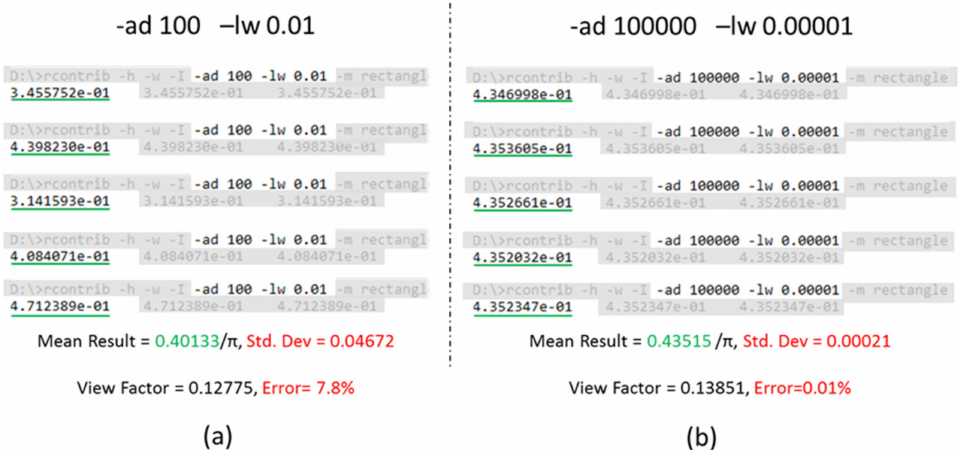
Figure 17. The impact of sampling parameters on accuracy and repeatability of results in five successive calculations. ( a ) Denotes low parameters with values of 100 and 0.01 for -ad and -lw respectively, and ( b ) denotes high